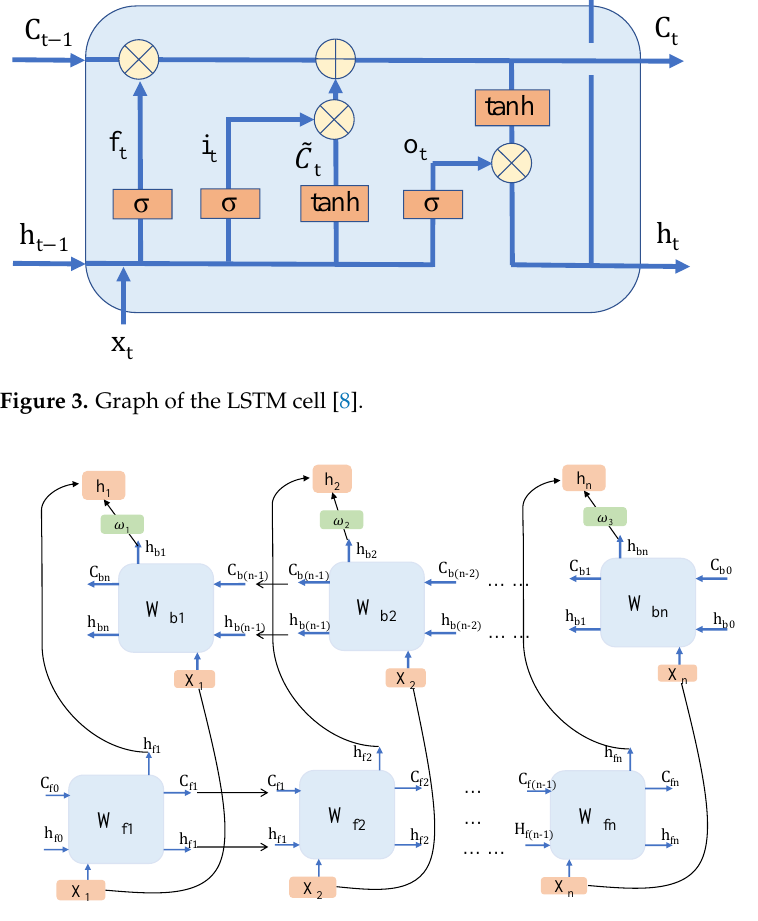
Figure 4. Graph of the weighted